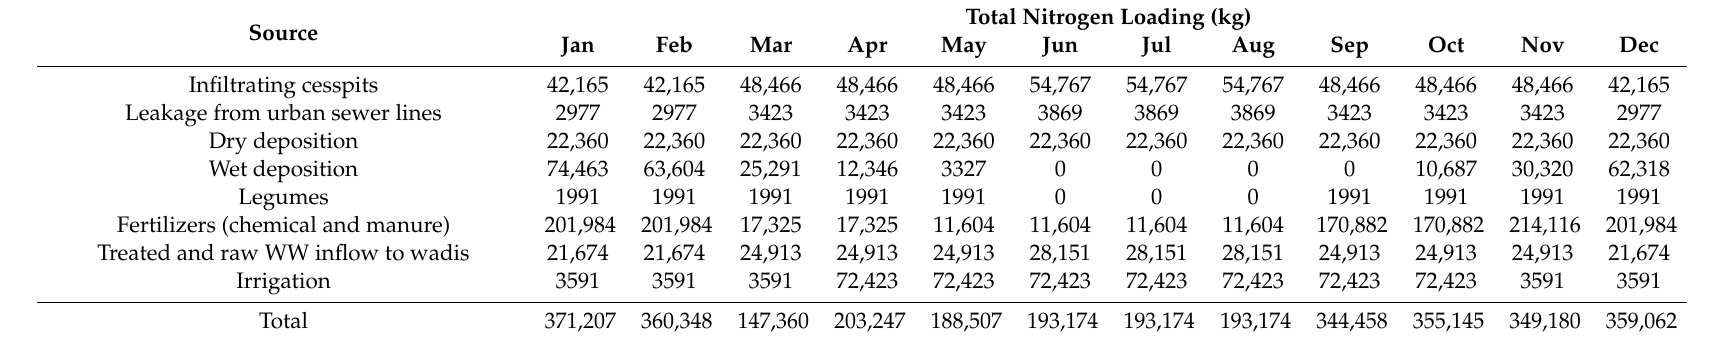
Table 5. Monthly on-ground nitrogen amounts (kg) in the area of the Eocene aquifer.